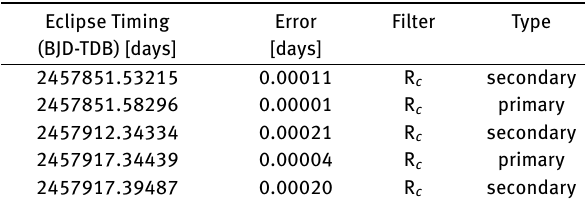
Table 1. Times of The Primary and Secondary Minima Derived From T100 Light